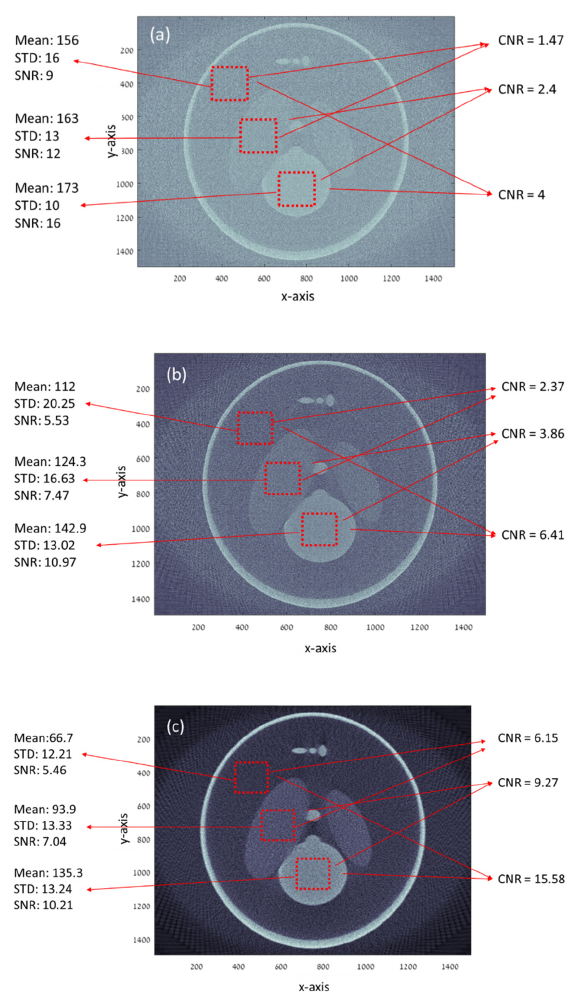
Figure 2. Simulation results of the modified Shepp–Logan phantom for the current CT geometry with different dose represented by the number of radiation rays: ( a ) 750,000 rays per view and ( b ) 3,000,000 rays per view and ( c ) the results for the proposed geometry with 750,000 rays per view (4 images of 187,500 rays per view) that corresponds to the number of rays in ( a ).